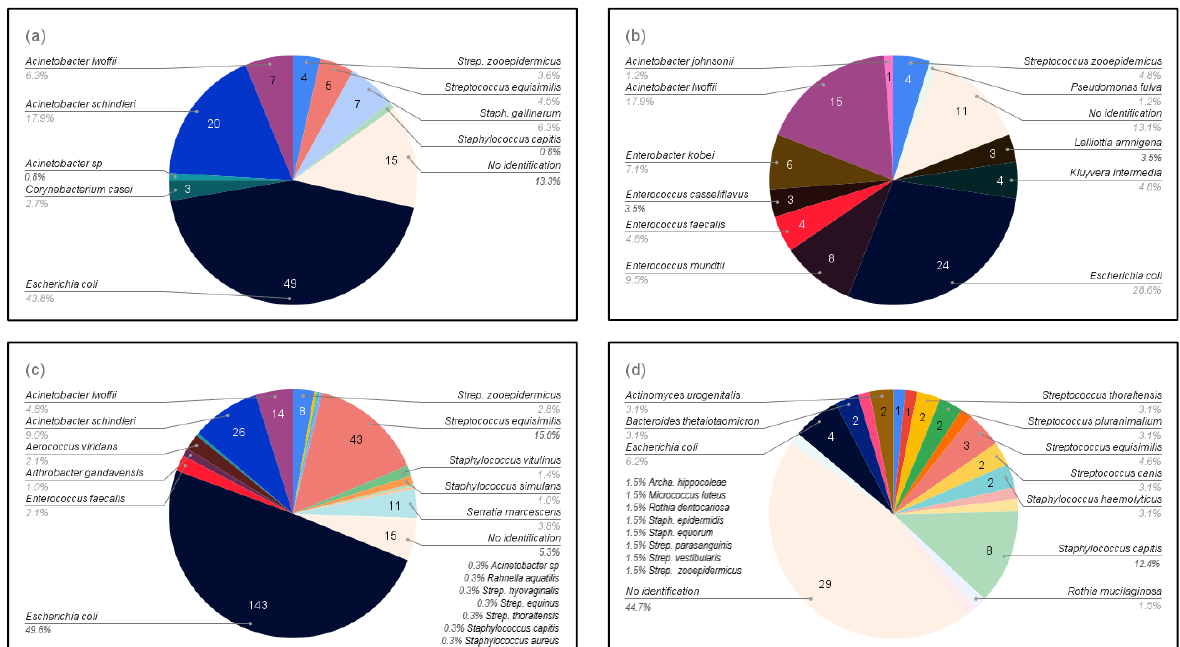
Figure 2. Bacteria isolated from the four groups of mares according to reproductive status: ( a ) Maiden mares in the stud farm in Boden (study 1); ( b ) Maiden mares in other farms in Boden (study 1); ( c ) Broodmares in the stud farm in Boden (study 1); and ( d ) Barren mares in Uppsala, including samples both before and after sham-insemination with semen extenders (study 2).